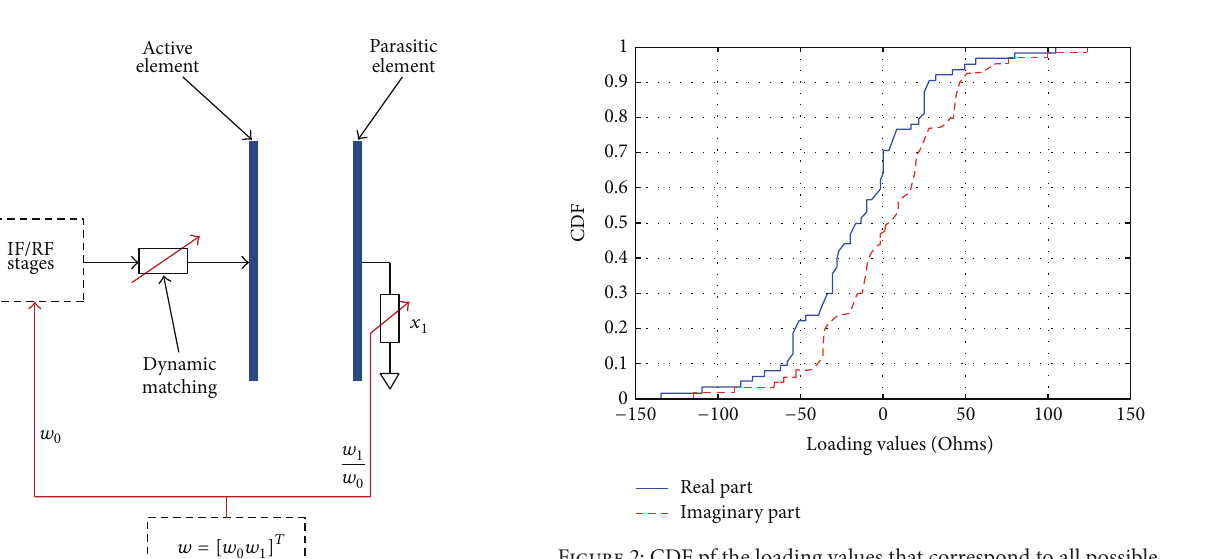
Figure 2: CDF pf the loading values that correspond to all possible 16-QAM symbol